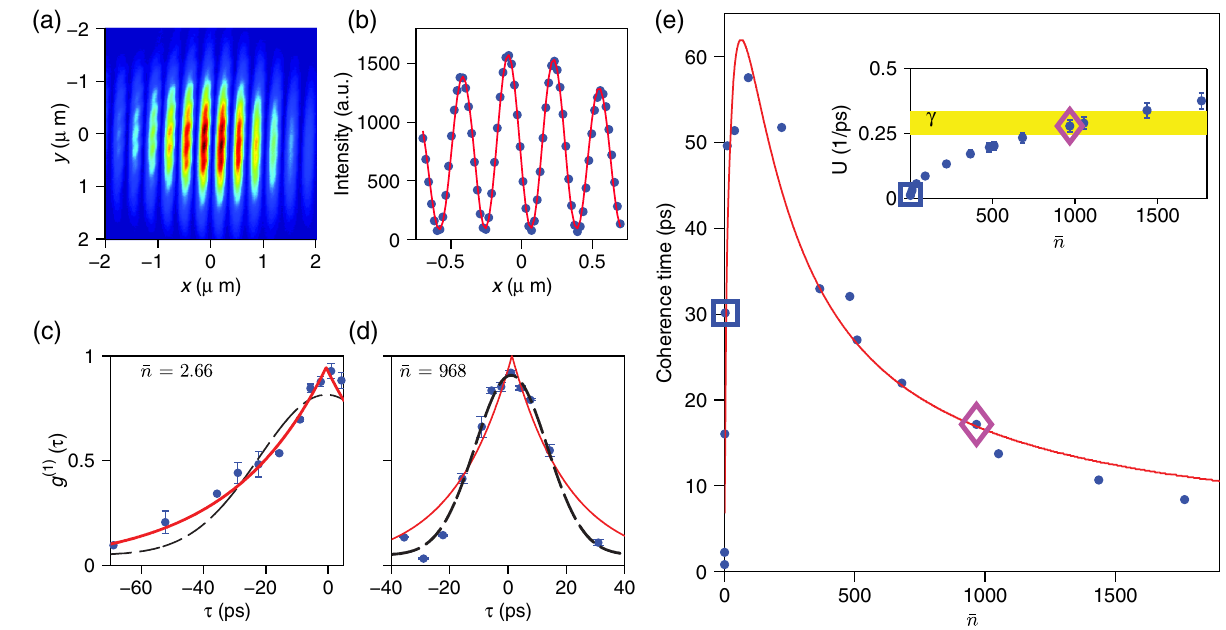
of the polariton laser vs ¯ n . c